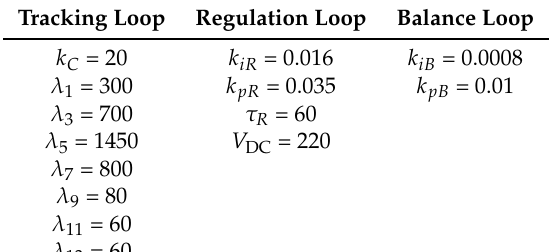
Table 3. Controller parameters.